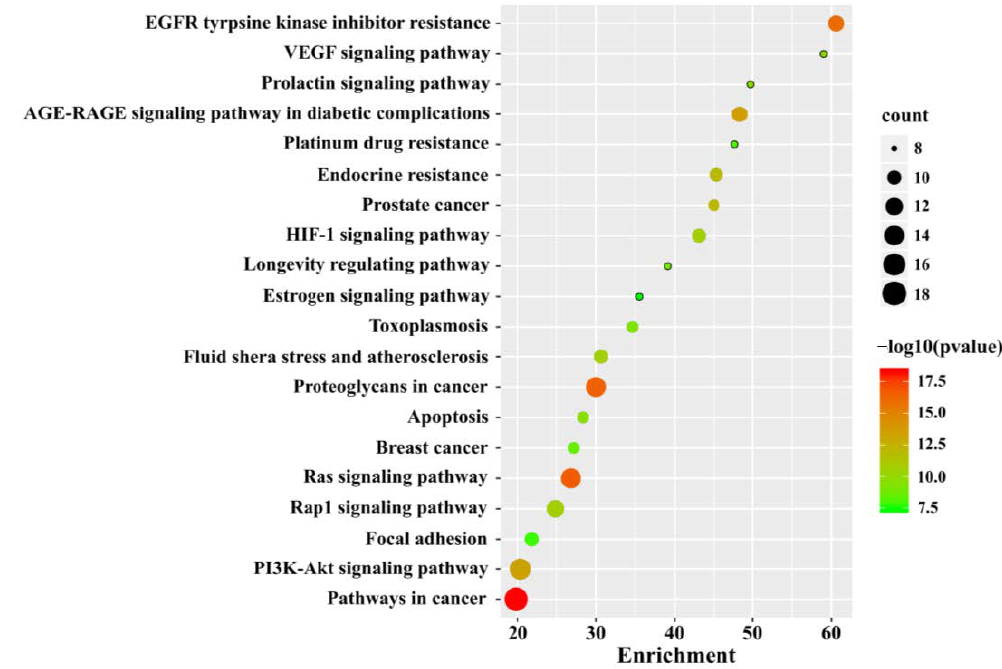
Figure 5. Kyoto Encyclopedia of Genes and Genomes (KEGG) analysis for NT-CTs. The top 20 pathways are shown. The size of the node represents the number of target genes in the pathway and the color of the dot reflects the − log10( p value).